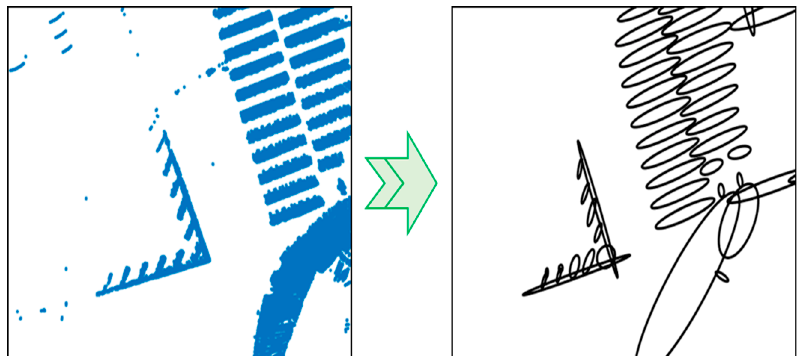
Figure 16. Result of probability distributions transform.